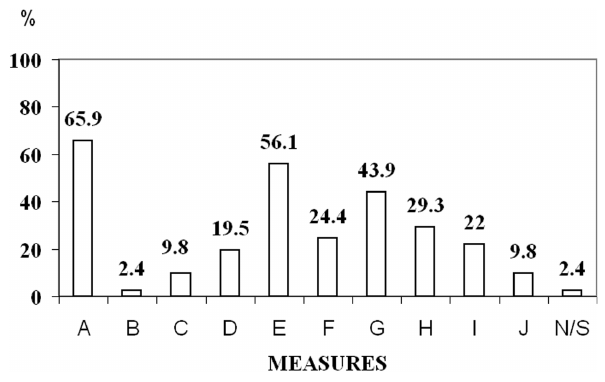
Fig. 11. Preferences for different management measures. All resi- dents.